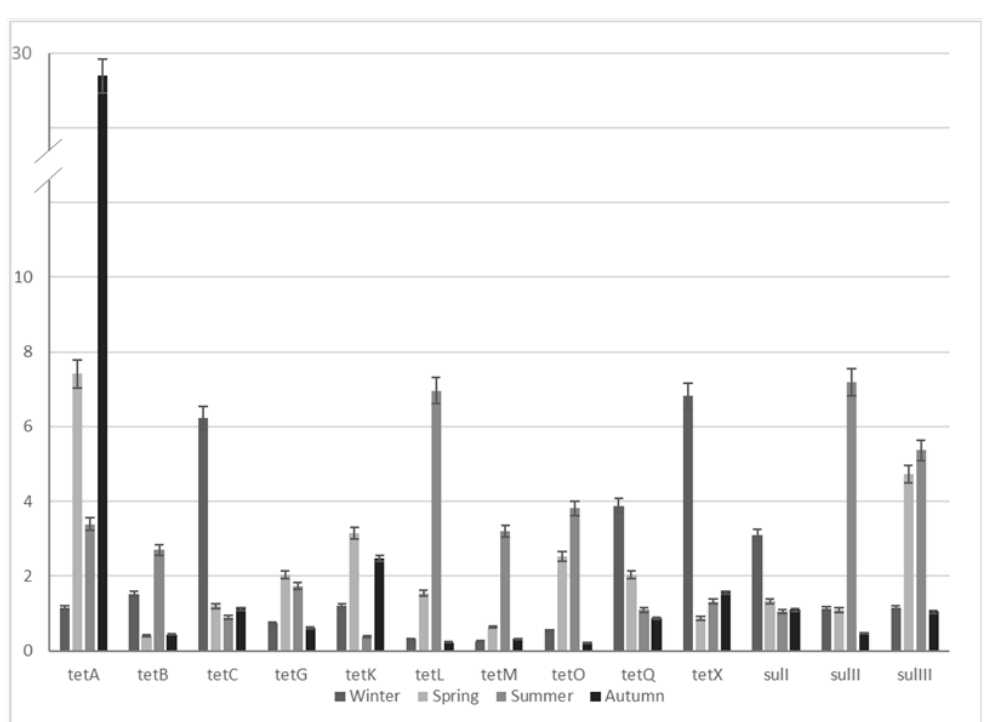
Figure 2. Enrichment of selected ARGs in the WWTP2 samples.